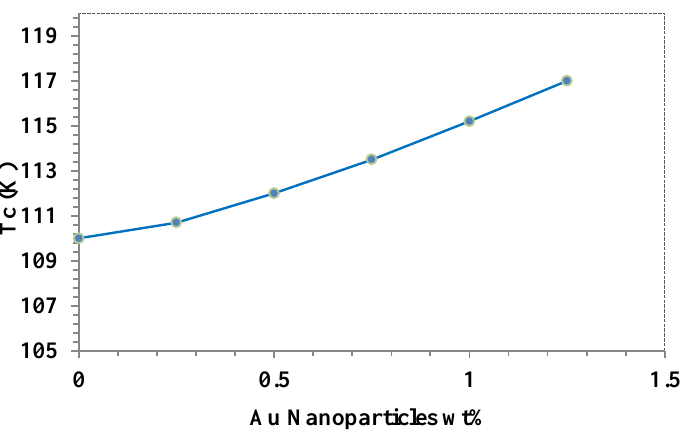
Fig. 4: Variation of critical temperature 𝑻